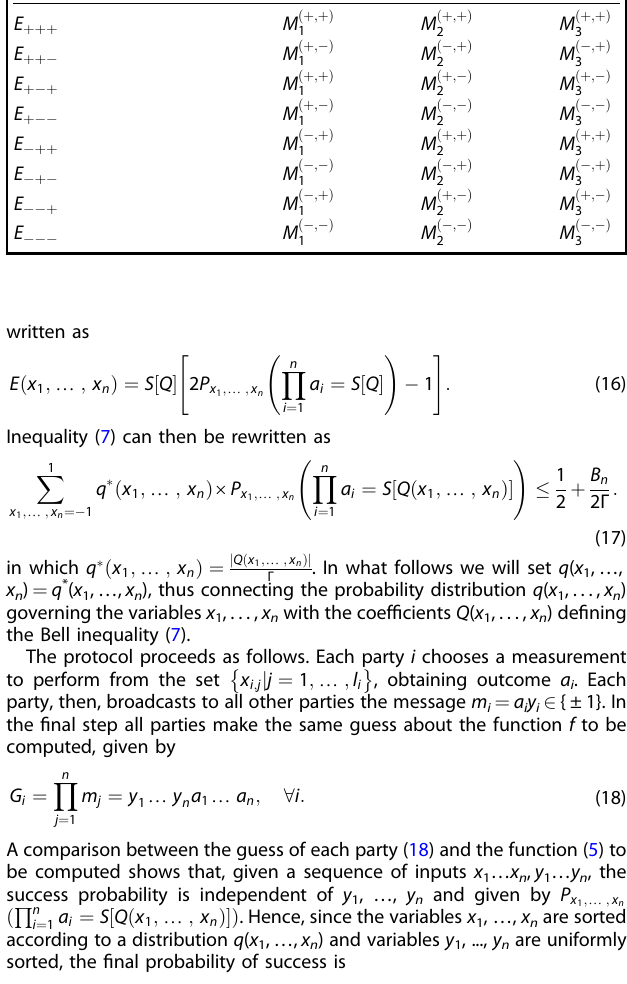
Table 2. Measurement settings for measurements of each correlator term in the three-user GYNI inequality. Measurement